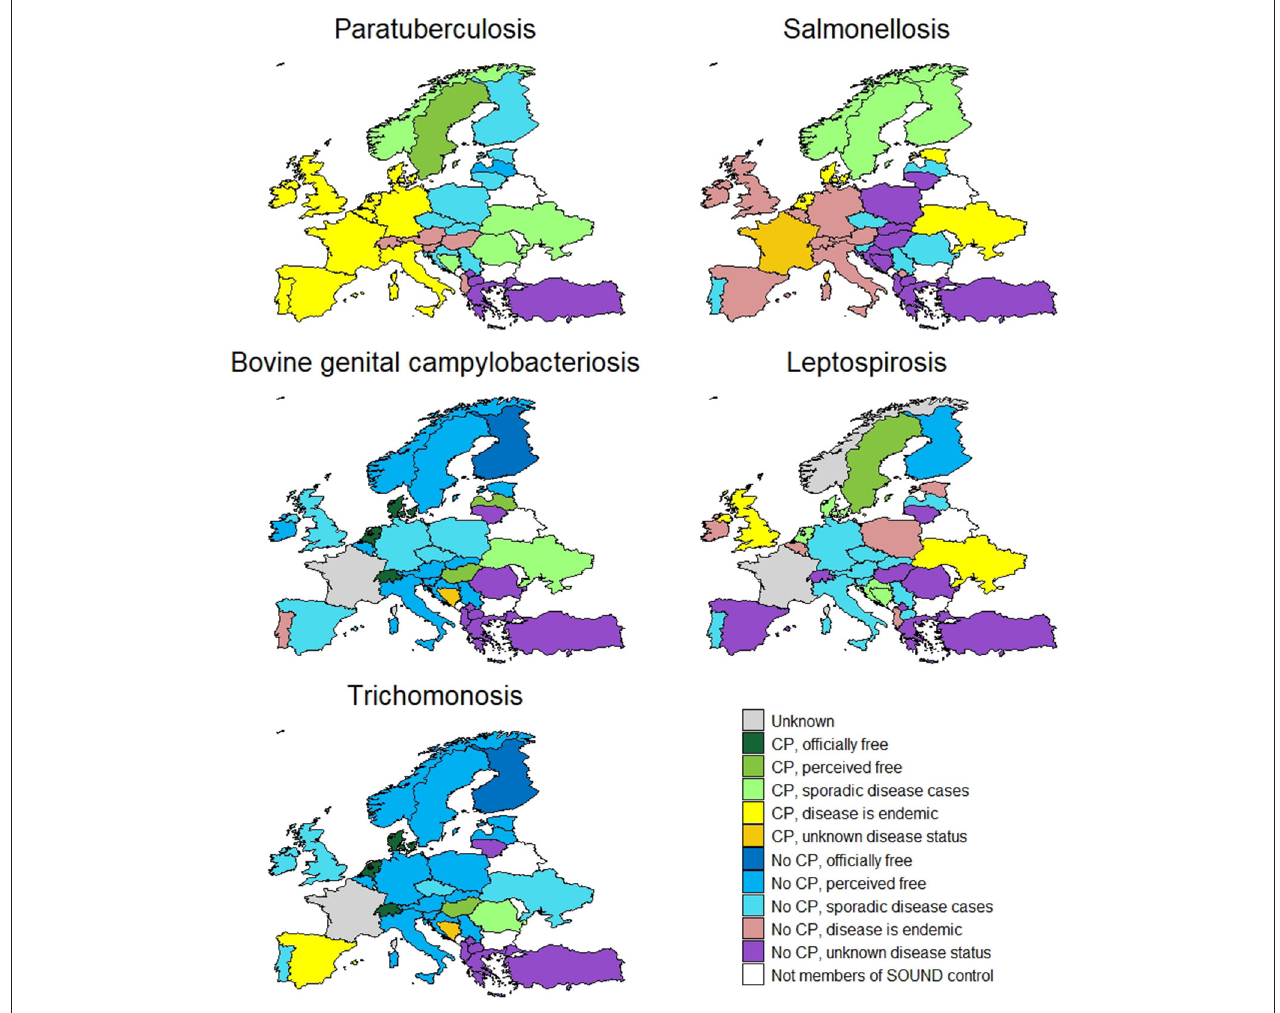
FIGURE 5 | Country level information on control programme implementation and disease status for paratuberculosis, salmonellosis, bovine genital campylobacteriosis, leptospirosis and